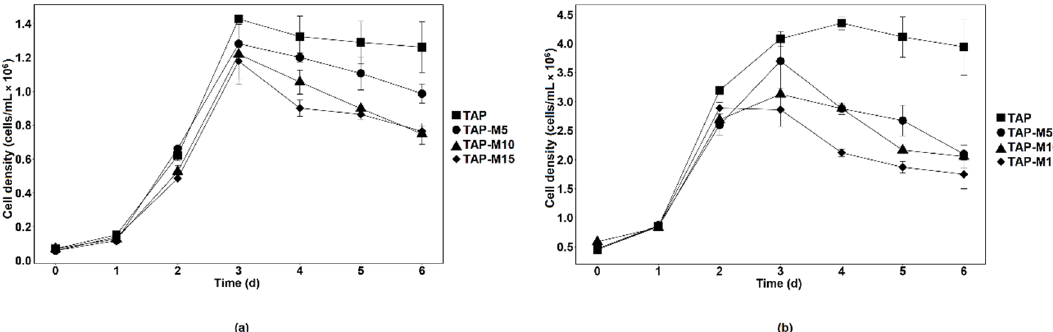
Figure 1. Growth of Chlamydomonas sp. MACC-216 ( a ) and Chlorella sp. MACC-360 ( b ) in TAP, TAP-M5, TAP-M10 and TAP-M15. Error bars represent standard deviations.